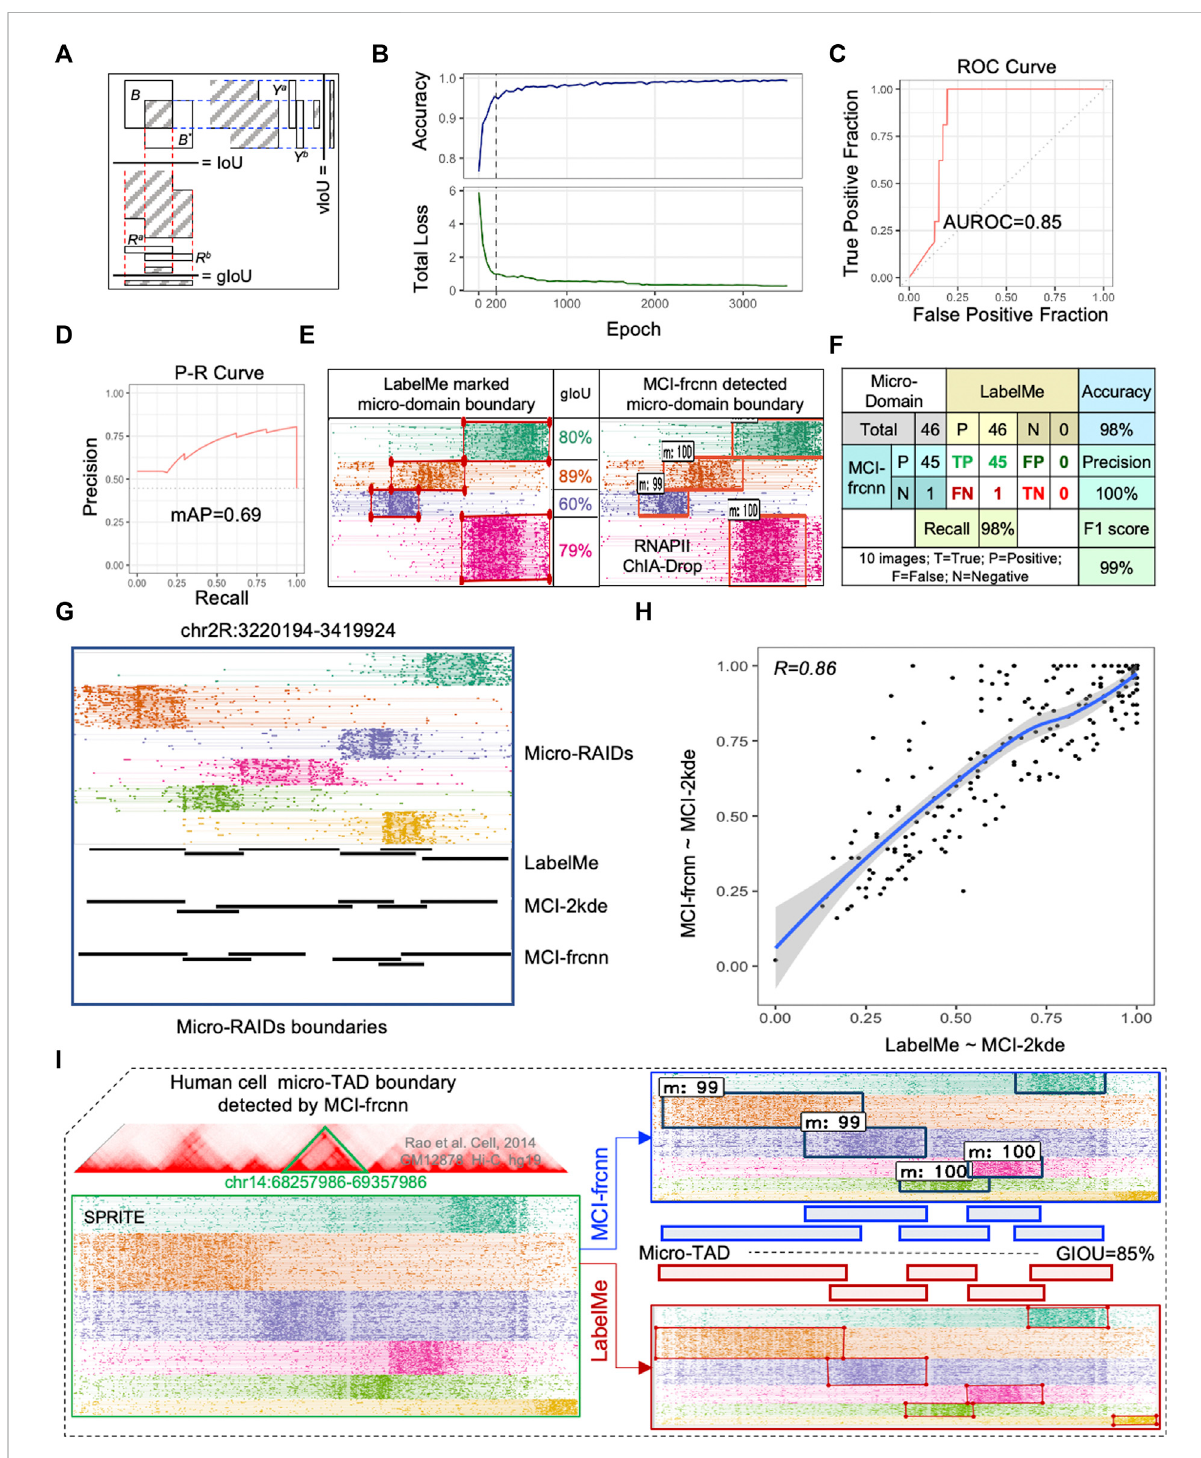
FIGURE 3 MCI-frcnn Performance. (A) Illustration of values of the intersection over union value (IoU), genomic IoU (gIoU), and vertical IoU (vIoU). (B) Curves of classi fi er accuracy for bounding boxes from RPN, and the total loss value of Faster R-CNN ( total_loss = loss_rpn_regression + loss_rpn_classi fi er + loss_detector_classi fi er + loss_detector_regression ). (C) Receiver operator characteristic (ROC) curve and the value of area under ROC curve (AUROC). (D) Precision-Recall (P-R) curve and mean average precision value (mAP). (E) Example of micro-domains genomic boundariesdetected byMCI-frcnn machine,togetherwithgIoUswhencomparedwiththeirgroundtruthgenomic regions. (F) Errors obtained from the 46 micro-RAIDs from the 10 testing images listed in Figure 4, including values of accuracy, precision, recall, and F1 score, by comparing MCI-